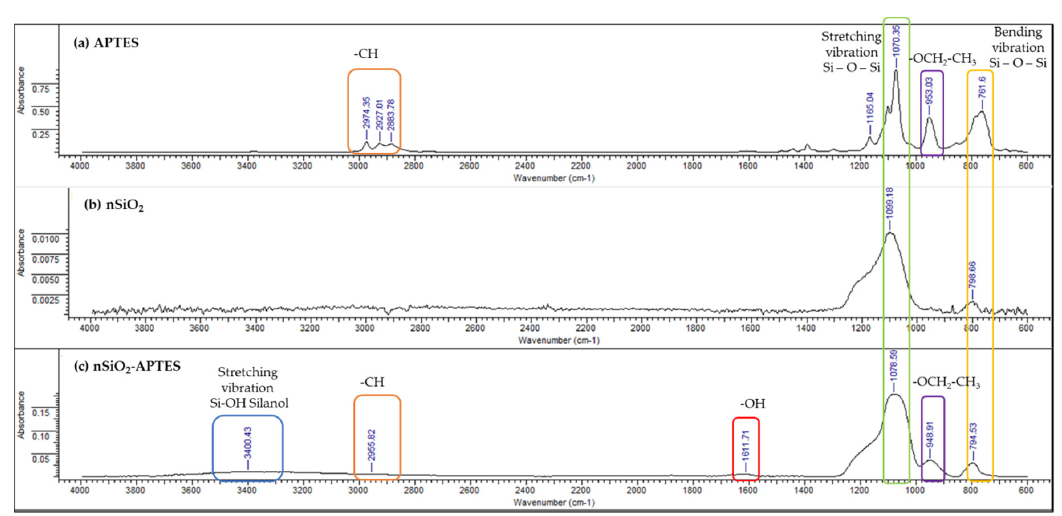
Figure 9. Infrared spectra of ( a ) APTES, ( b ) nSiO 2 and ( c ) nSiO 2 -APTES NPs .